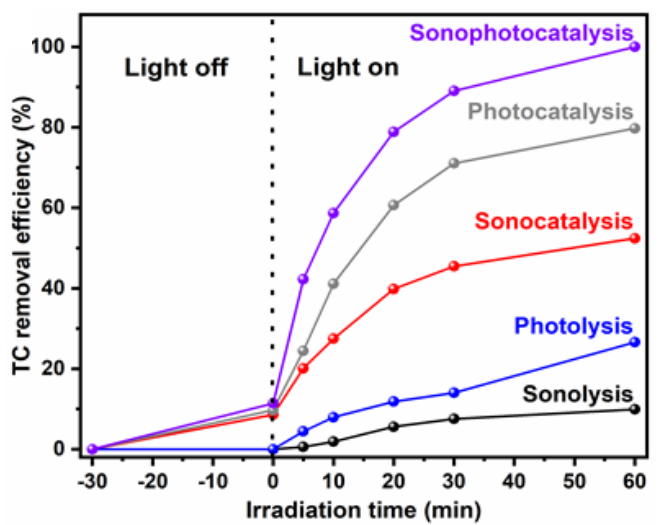
Figure 12. Comparison of the TC removal efficiency as a function of irradiation time. Reprinted with permission from [47].